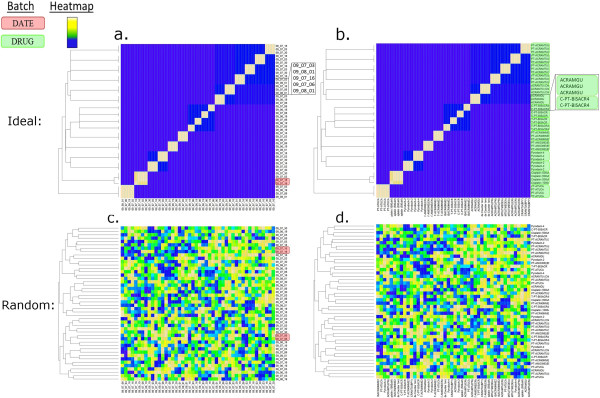
Shabtai et al. Ideal and random outcome of TAG4 Microarray dataset cluster. Expected results of an ideal outcome and a random outcome. The left column displays the cluster of experiments where the labels are the dates on which the experiment was performed (a, c). Adjacent identical dates are displayed in a red rectangle to indicate when clustering occurs by date. The right column displays the cluster of experiments where the labels are the chemical compound that was used for each experiment (b, d). Adjacent identical chemical compounds are displayed in a green rectangle as shown in the legend, to indicate when the same chemical compounds are clustering together. The ideal result shows that experiments, performed using the same chemical compound, cluster together according to chemical compounds, where each cluster can be seen in a green rectangle (b). The ideal result also shows that the experiments cluster by date only when they were performed using the same chemical compound (a). The random score did not cluster any of the experiments according to chemical compound (d), and clustered experiments by date only by chance.